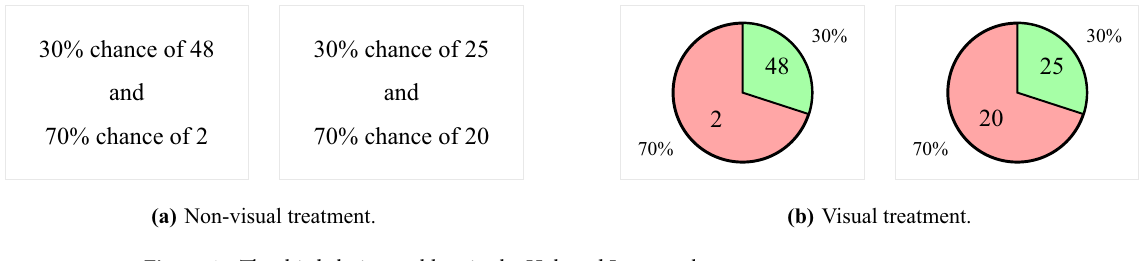
Figure 1. The third choice problem in the Holt and Laury